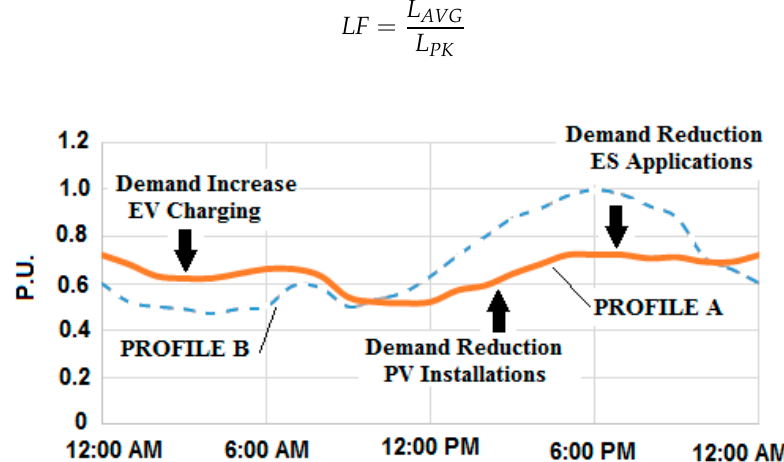
Figure 2. DER effects on historical load profile that result in a flattened load profile (Profile A).